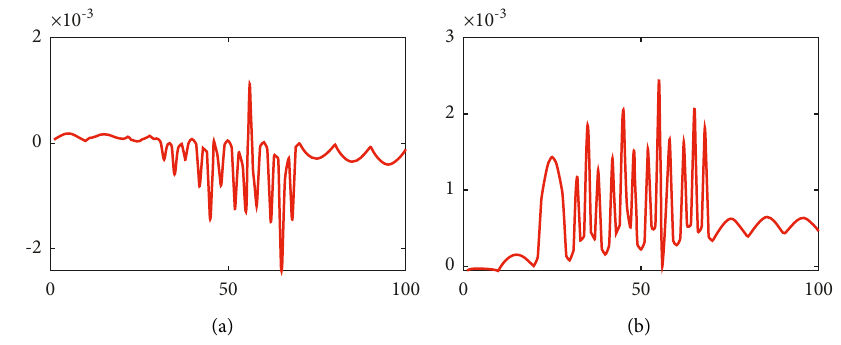
Figure 11: The error curves for the scatterer with complex permittivity. (a) Real part. (b) Imaginary part.